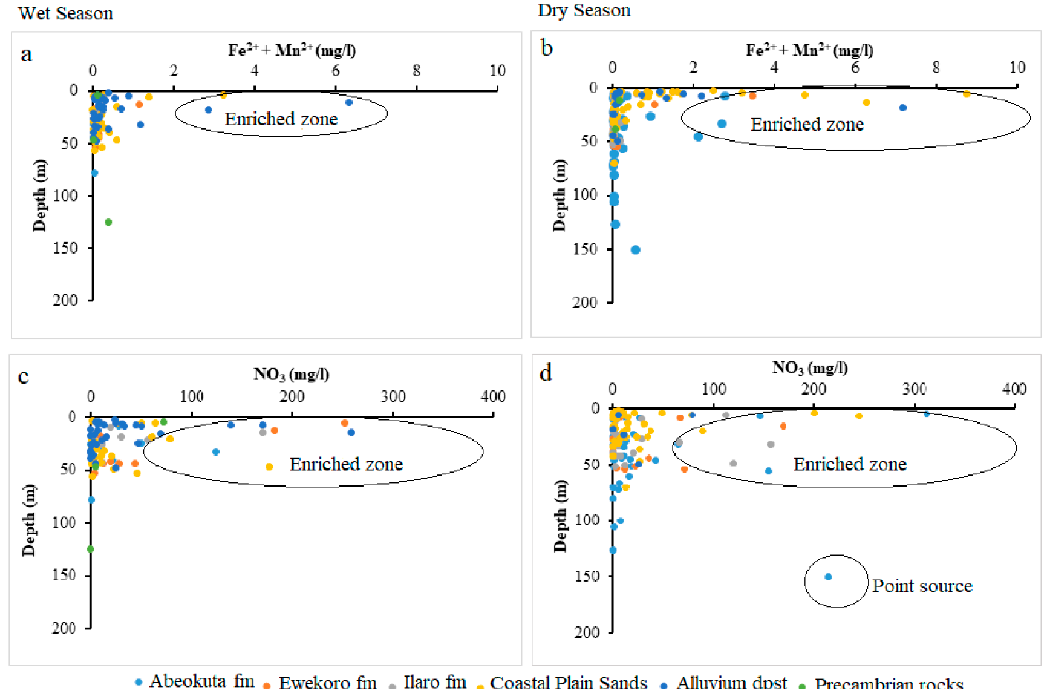
Figure 11. Scatter plots (Fe 2 + + Mn 2 + ) against well depth ( a ) wet season ( b ) dry season and NO 3 against well depth ( c ) wet season ( d ) dry season.